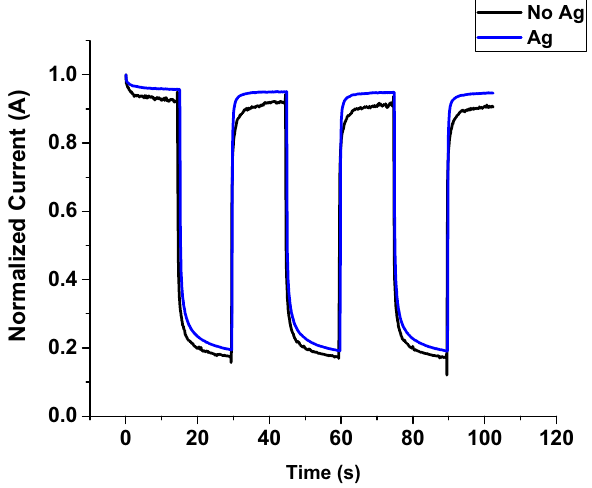
Figure 15. Transient response of the UV photodetector fabricated based on Au/β-Ga 2 O 3 /Au MSM at 5 V without and with Ag catalyst.